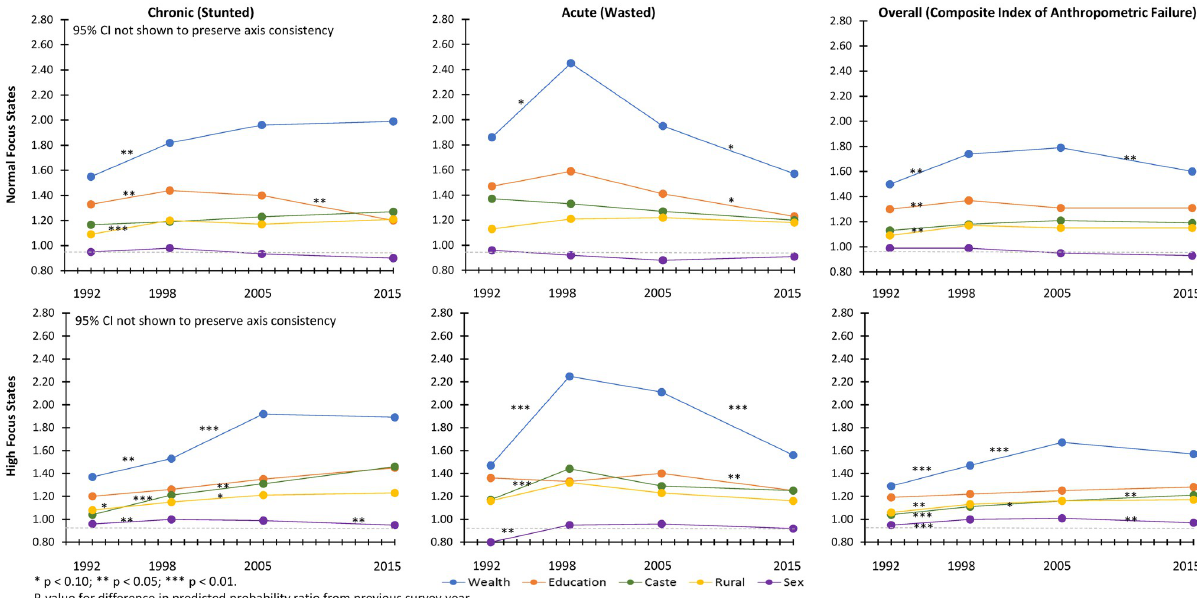
Fig 4. Trends in socioeconomic disparities for child undernutrition among normal focus and high-focus states. Data from the 1992, 1998, 2005, and 2015 NFHS. CI, confidence interval; NFHS, National Family Health Survey. Predicted probability ratio for wealth (lowest quintile/highest quintile), maternal education (none/secondary or higher), caste (scheduled caste or tribe/general), location of residence (rural/urban), and child sex (female/ male) were estimated after mutually adjusting for each other as well as child’s age, birth order, religion, and maternal age. Northeast focus states not shown because prevalence ratio were not estimable due to small sample